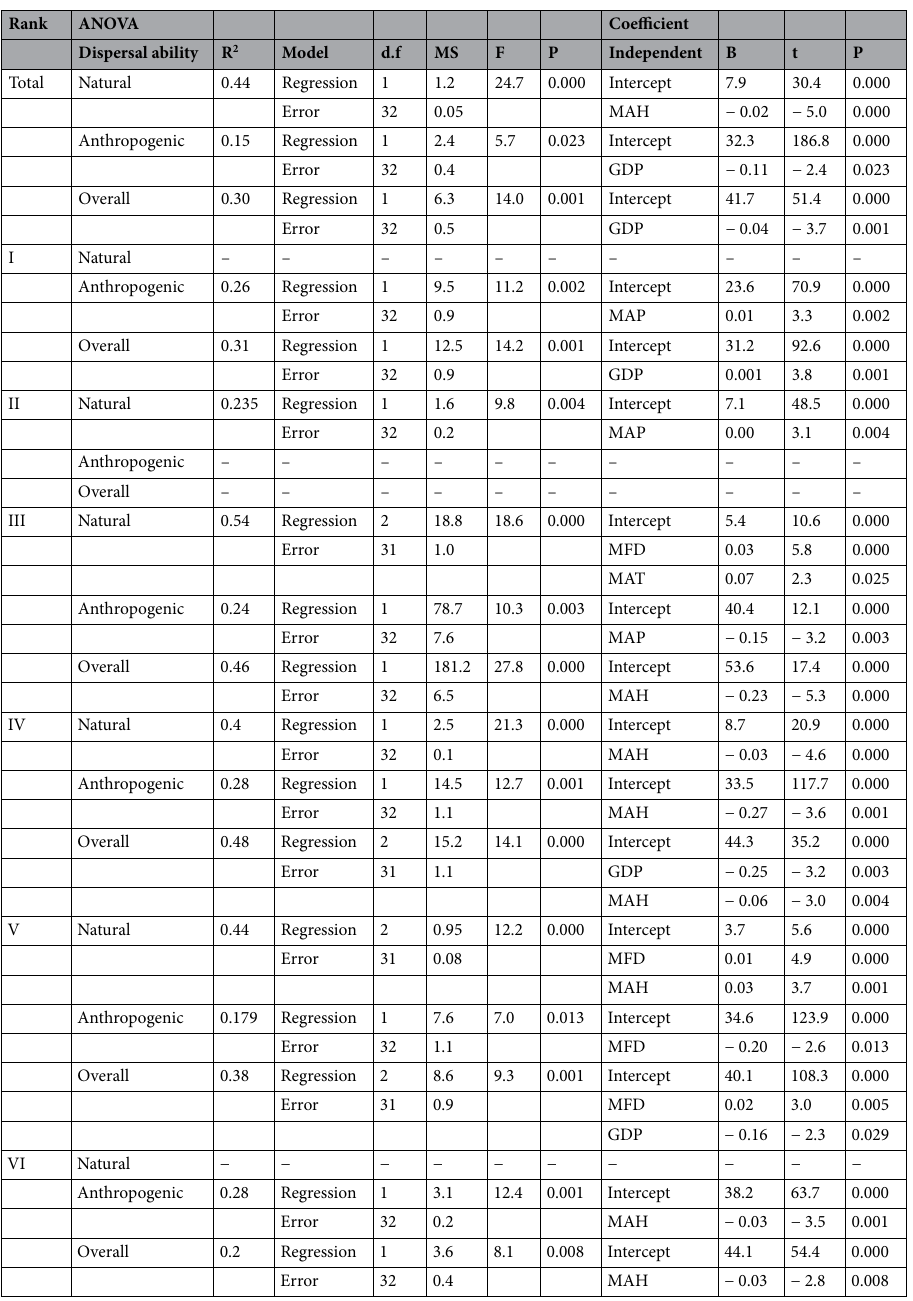
Table 3. ANOVA analysis and estimation of regression coefficients among the natural, anthropogenic, and overall dispersal abilities and socio-climatic factors for all alien plant species and each of the six risk ranks